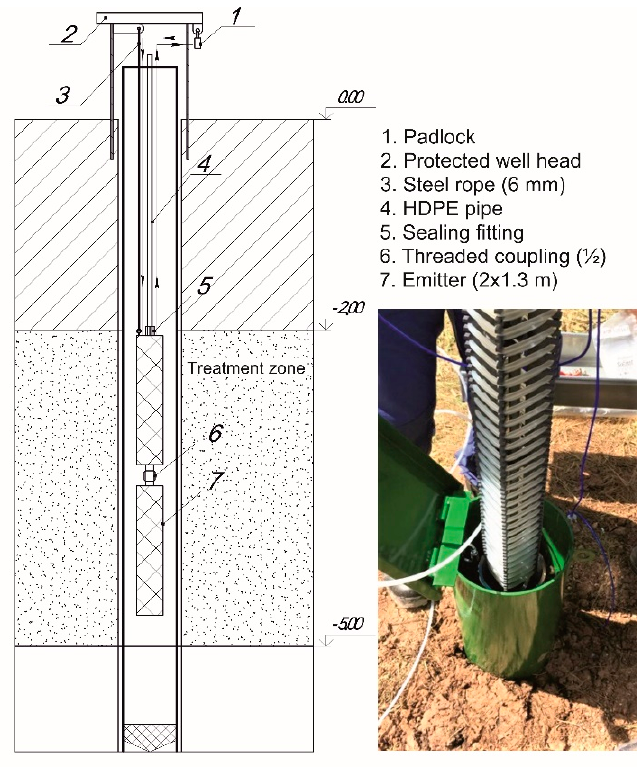
Figure 3. Construction of treatment well with emitter.